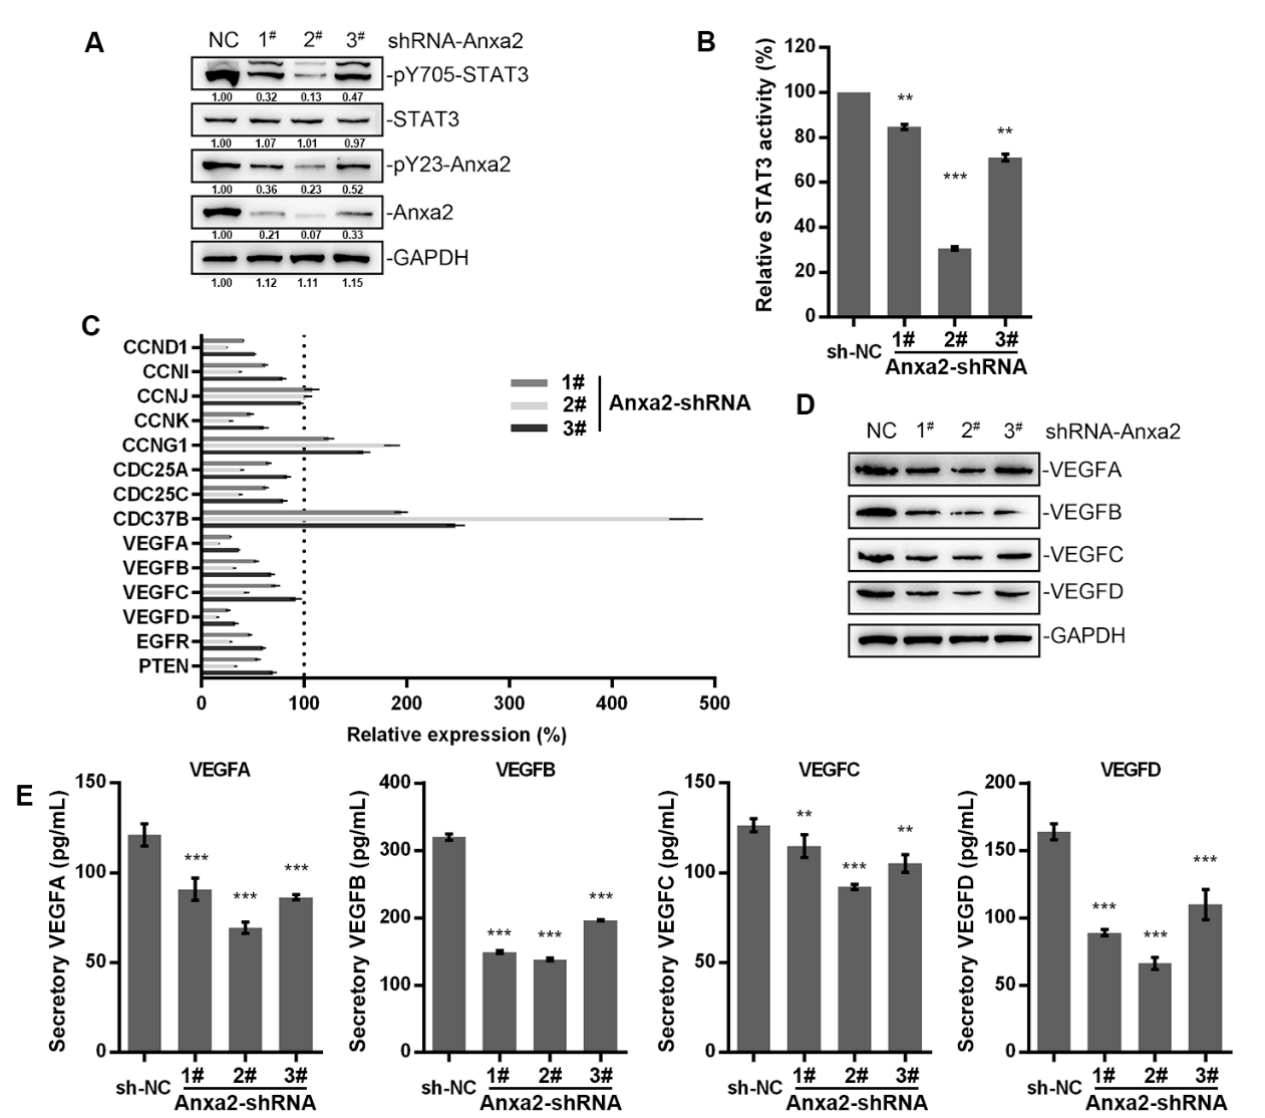
Figure 1. Anxa2 regulated the expression of VEGFs. HepG2 cells were treated with three different Anxa2-shRNAs. ( A ) Protein level and phosphorylation status of STAT3 and Anxa2 were determined by immuno-blotting. ( B ) The activation of STAT3 was determined via reporter gene assay. ( C ) The expression of STAT3 target genes was determined by qRT-PCR. ( D ) The protein level of four VEGFs was determined by immuno-blotting. ( E ) The concentration of four VEGFs in cell-free supernatant was determined by ELISA. All experiments were performed with triple replicant. Significance analysis was shown as ** ( p < 0.01) and *** ( p < 0.001).